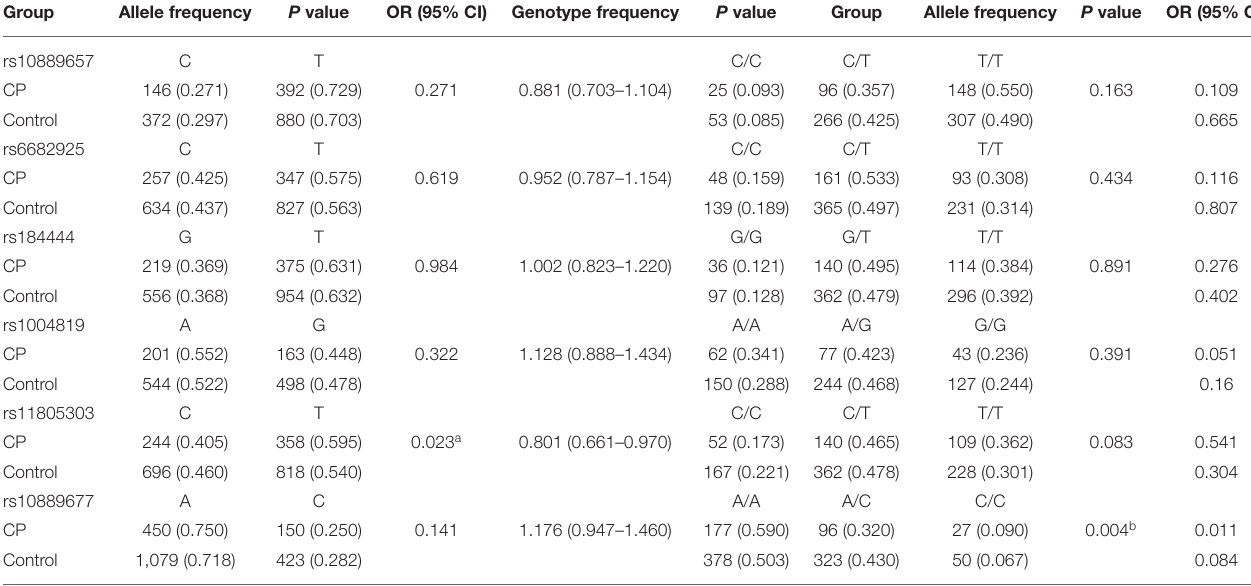
TABLE 5 | Allele and genotype frequencies of IL-23R in CP with NE and the control group. Group Allele